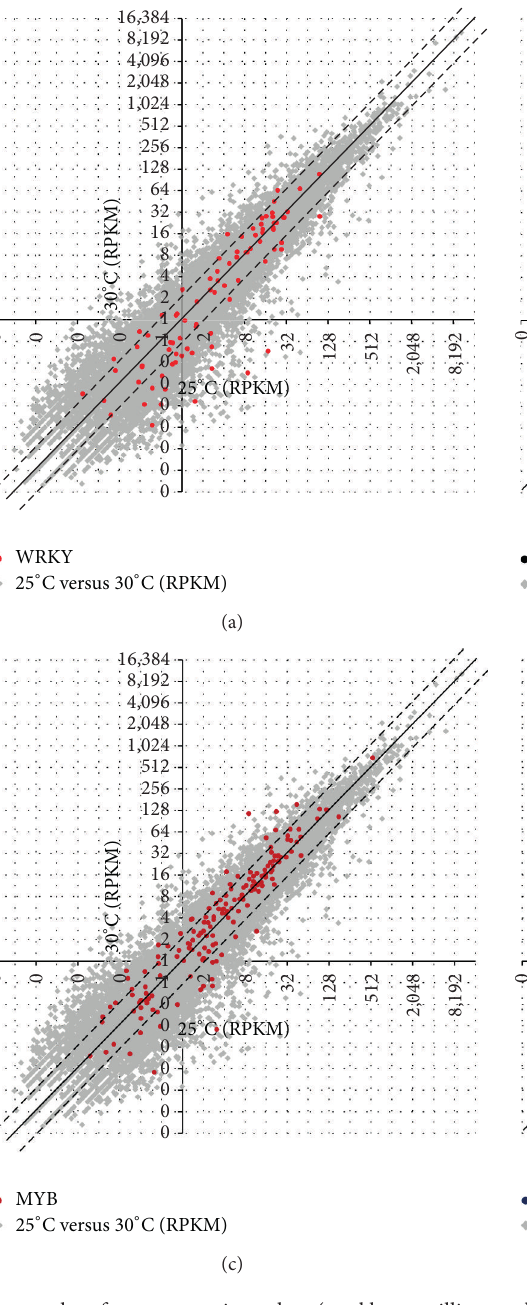
Figure 1: A scatter plot of gene expression values (per kb per million total reads, RPKM) in log2 scale for the 25 ∘ C versus 30 ∘ C datasets. Grey dots indicate each gene expressed in the two samples. Coloured dots indicate a specific group of genes. Two diagonal dashed lines indicate twofold changes (increases and